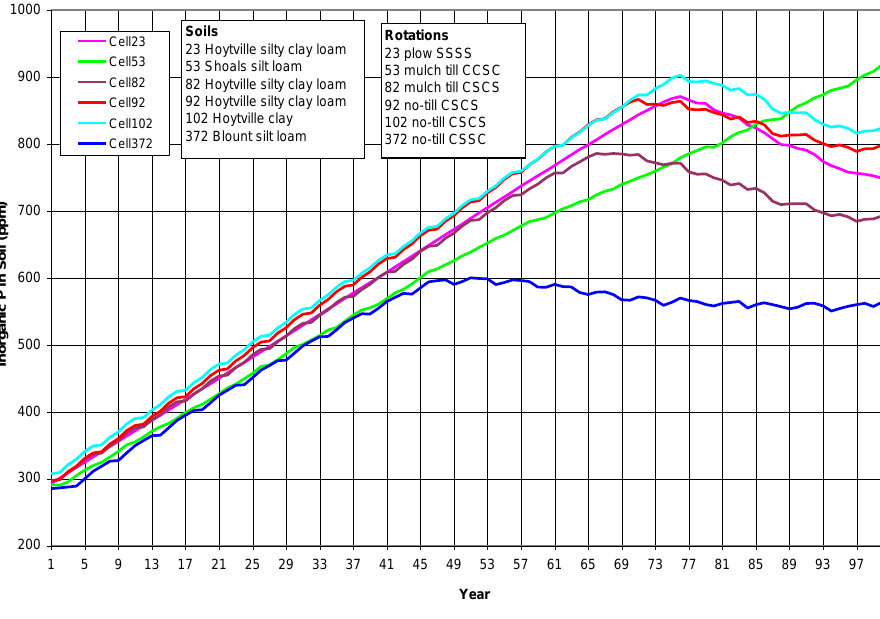
Figure 7 . In situ inorganic soil P for top 200-mm of the soil for six cells. Cells were arbitrarily chosen to represent different soils, crop rotations and tillage. SSSS refers to continuous soybean during 1999–2002, CCSC refers to corn-corn-soybean-corn rotation during 1999–2002, CSCS refers to corn-soybean-corn-soybean rotation during 1999–2002, and CSSC refers to corn- soybean -soybean-corn rotation during